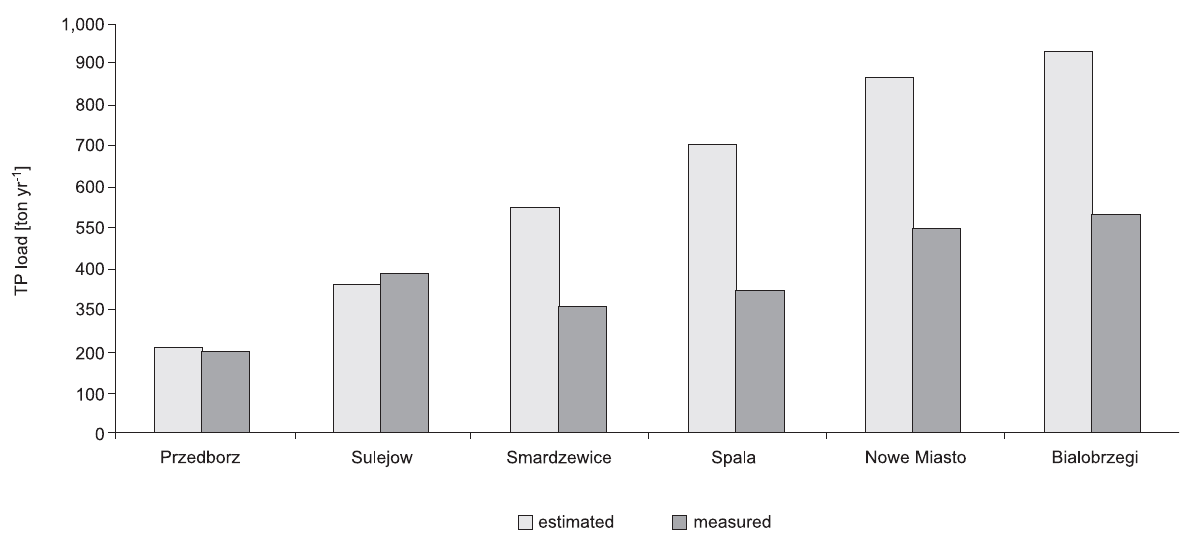
Fig. 6. Measured TP load in the period between 19 May 2010 and 19 May 2011 (Kiedrzyńska et al. 2014) and estimated TP load in monitoring points along the Pilica River located in the individual